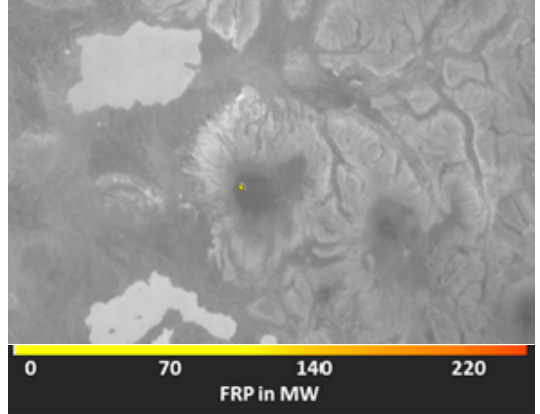
Figure 4: Calculated FRP from TET-1 image (22nd Feb.